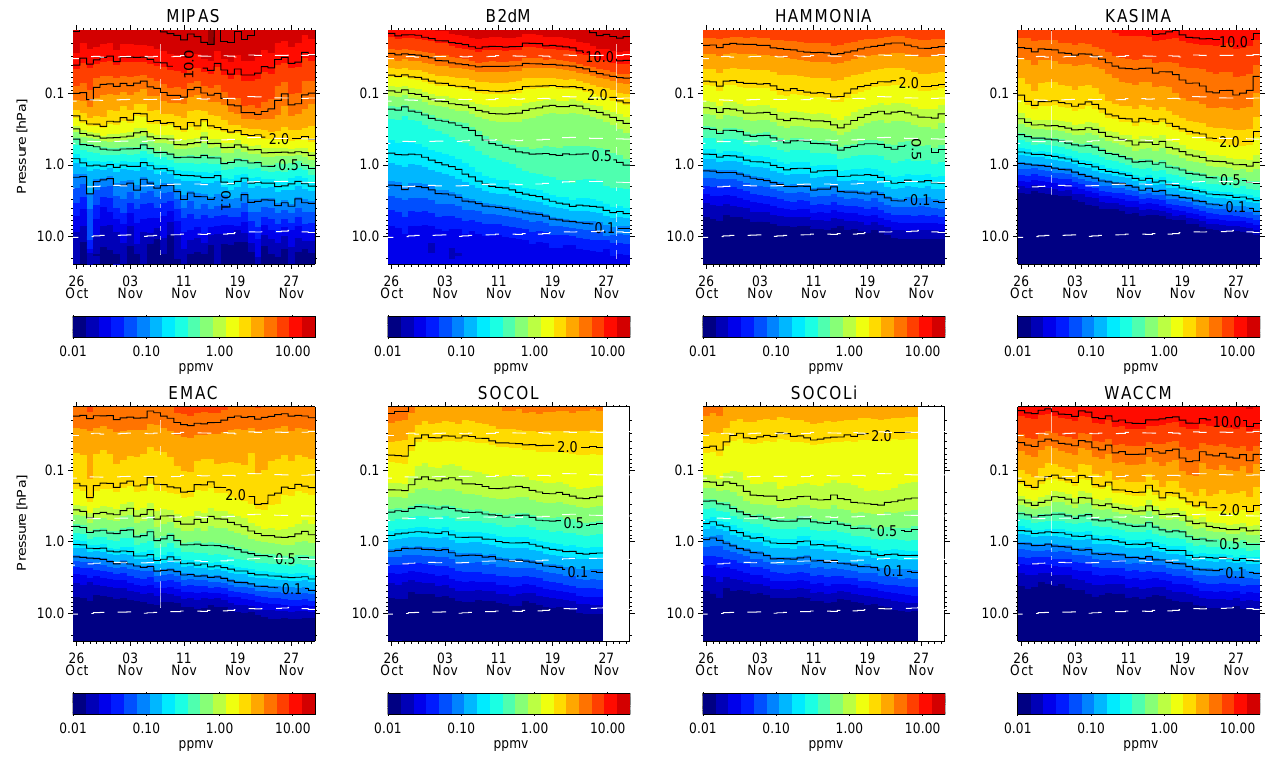
Fig. 11. Temporal evolution of CO abundances in MIPAS observations and model simulations averaged over 70–90 ◦ N. The 0.1, 0.2, 0.5, 1, 2, 5, 10, and 20ppmv contours are shown by solid lines.